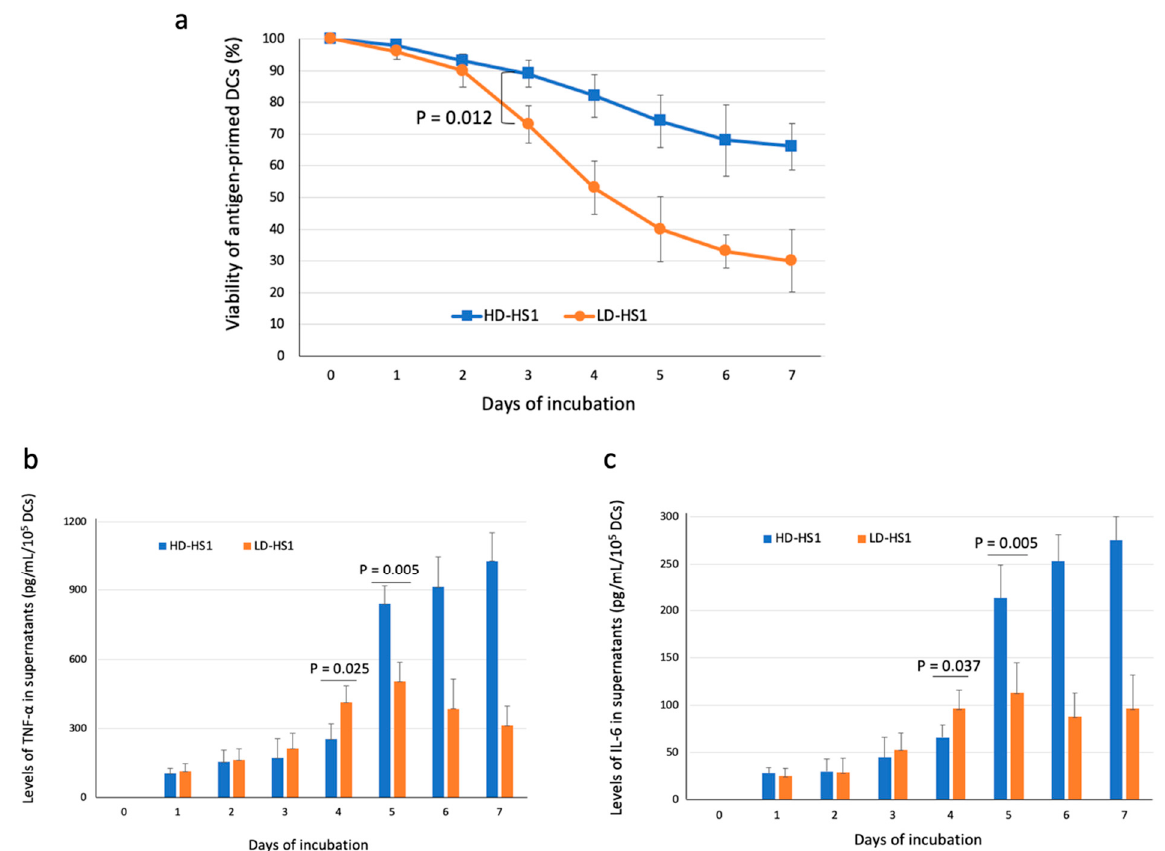
Figure 3. Kinetics of viability of DCs and production of proinflammatory cytokines in the in vitro DC-T cell model. ( a ) Viability of antigen-pulsed DCs in the incubation with CD8+ T cells (assessed by counting chamber with trypan blue dye exclusion); ( b ) TNF- α production in cell culture supernatants (assessed by ELISA); ( c ) IL-6 production in cell culture supernatants (assessed by ELISA). Data are presented as mean + SD among 10 subjects. Dose of individual antigens as following: LD-HS1 (low dose of S1 of SARS-CoV-2) as 110 ng/mL and HD-HS1 (high dose of S1 of SARS-CoV-2) as 550 ng/mL; p -values were determined by Wilcoxon signed-rank test.